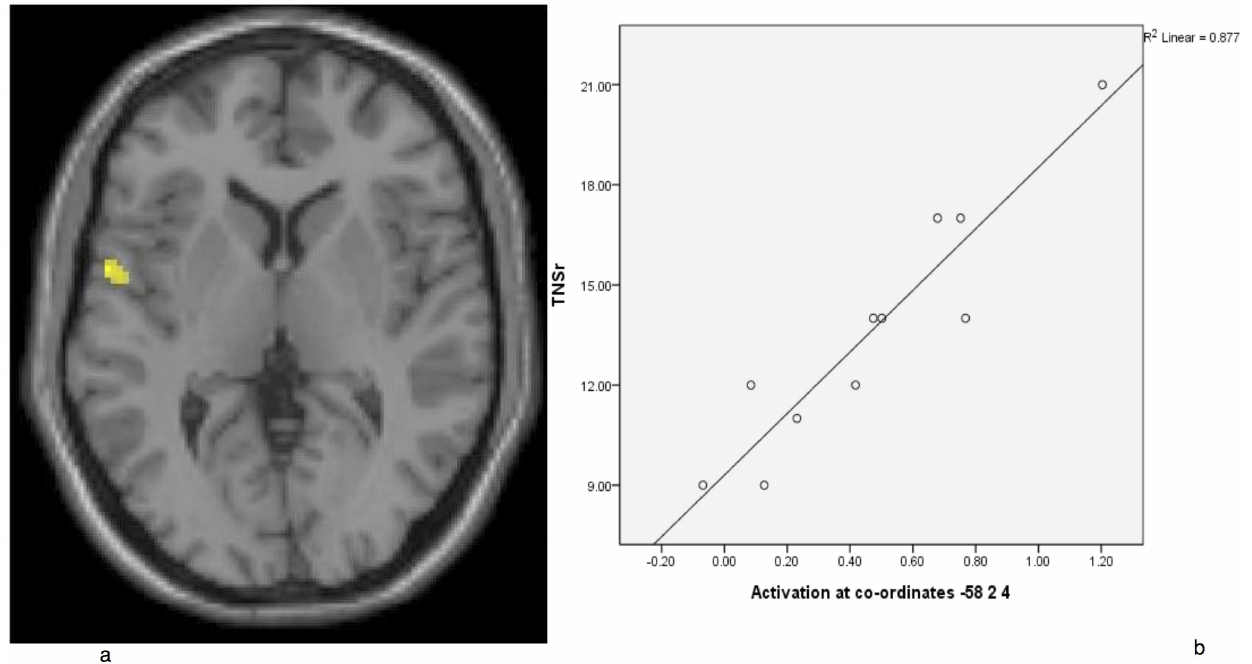
Figure 3. a: CIPN-myeloma patients demonstrated activation in the operculo-insular cortex. This activation was during painful heat stimulation, the degree of which correlated with TNS-reduced version. For display purposes, the statistical threshold is p , 0.001, uncorrected, at the voxel-level. b: Linear correlation between the TNS-reduced version and BOLD response within the operculo-insular cortex.